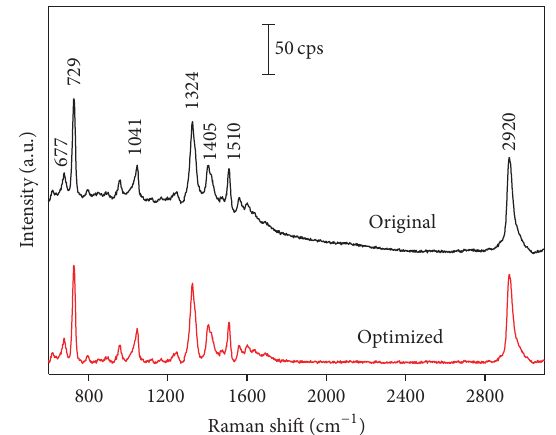
Figure 2: Model spectrum (black curve: 10g/L) and the results of applying the RCF method to the curves (red curve: parameters of the analyzing circle 𝑅 = 650 cm −1 and 𝑅 𝑥 /𝑅 𝑦 = 16cm −1 /rel. unit).